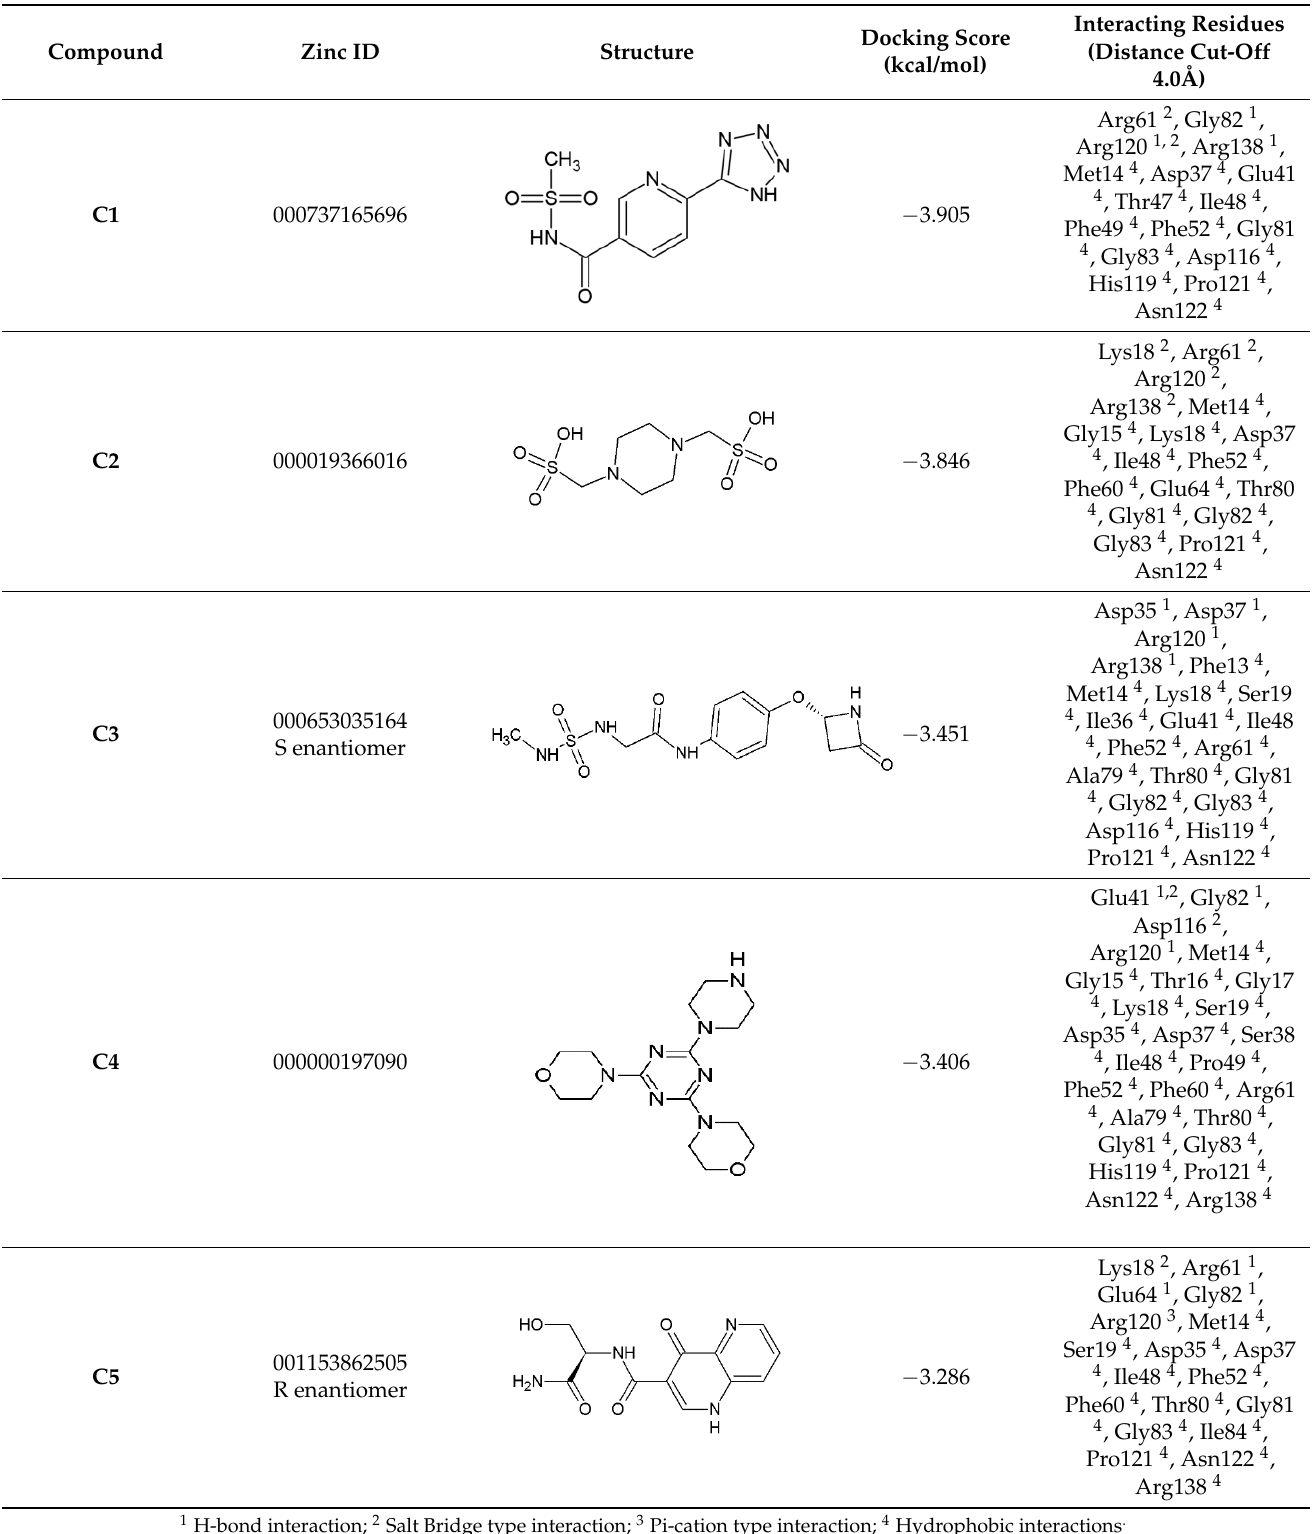
Table 1. Glide XP docking results for the top five